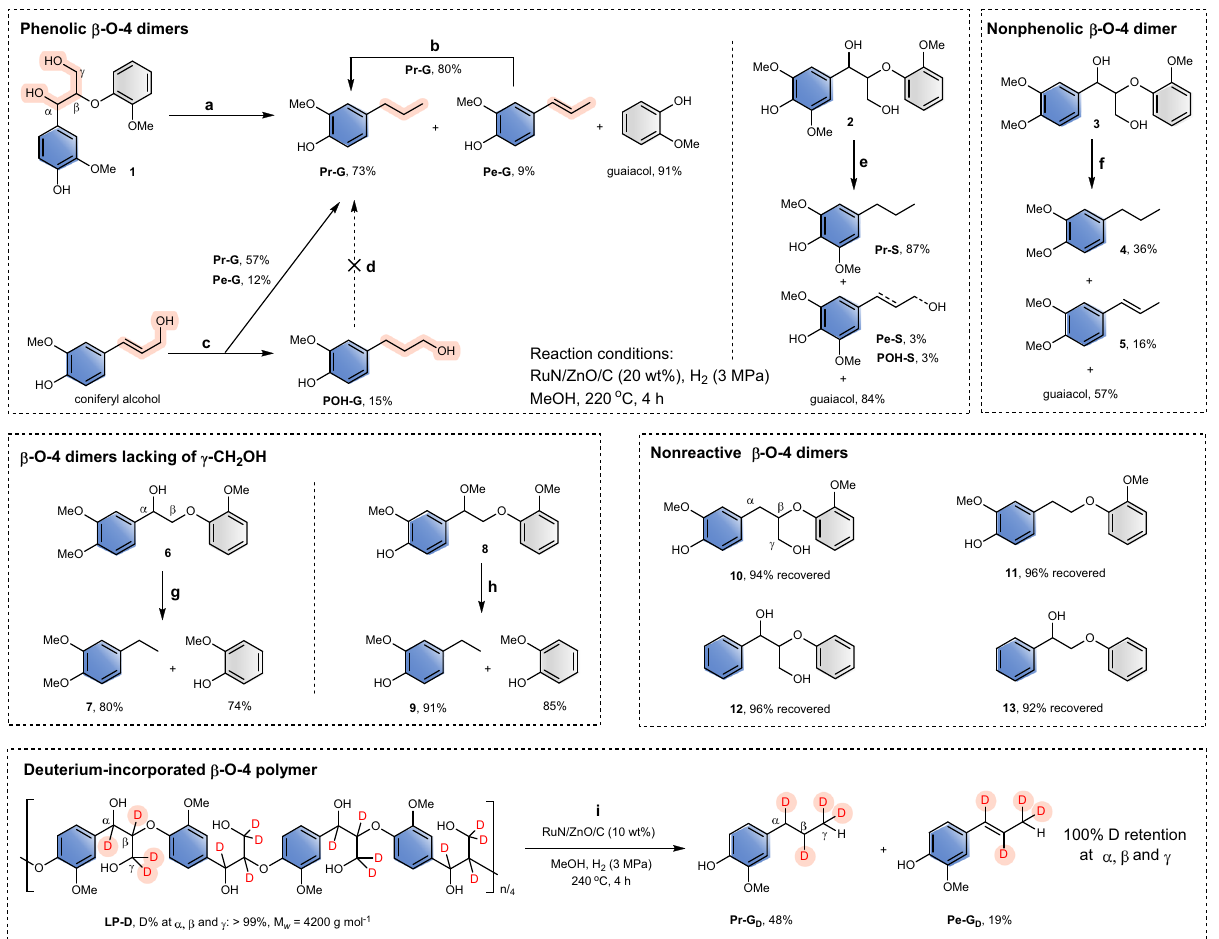
Fig. 8 | Reactivity of β - O -4 lignin mimics with RuN/ZnO/C. Reaction conditions for the other dimers: substrate (25mg), RuN/ZnO/C (5mg, 20wt%), MeOH (15mL), 220 °C, H 2 (3MPa at 25 °C), and